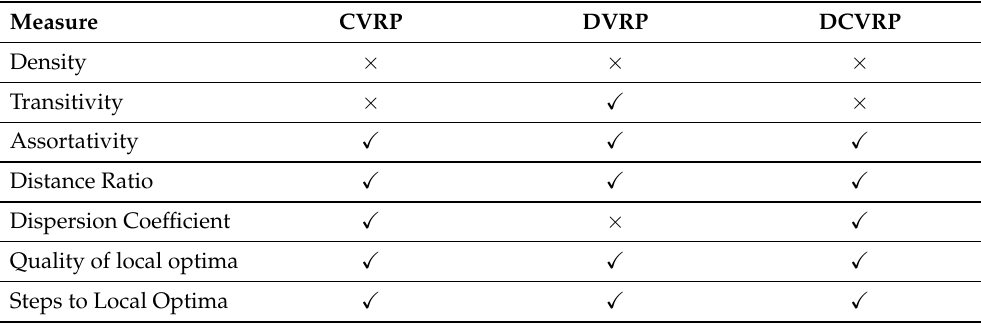
Table 7. Significance of the variables for Logistic Regression to identify difficulty of instances. Statistically significant variables ( α = 0.05) are represented with ( (cid:88) ).